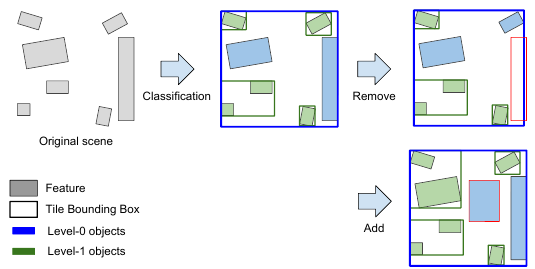
Figure 3: Manipulation data with our proposed structure: classi- fication, addition and removal of data.